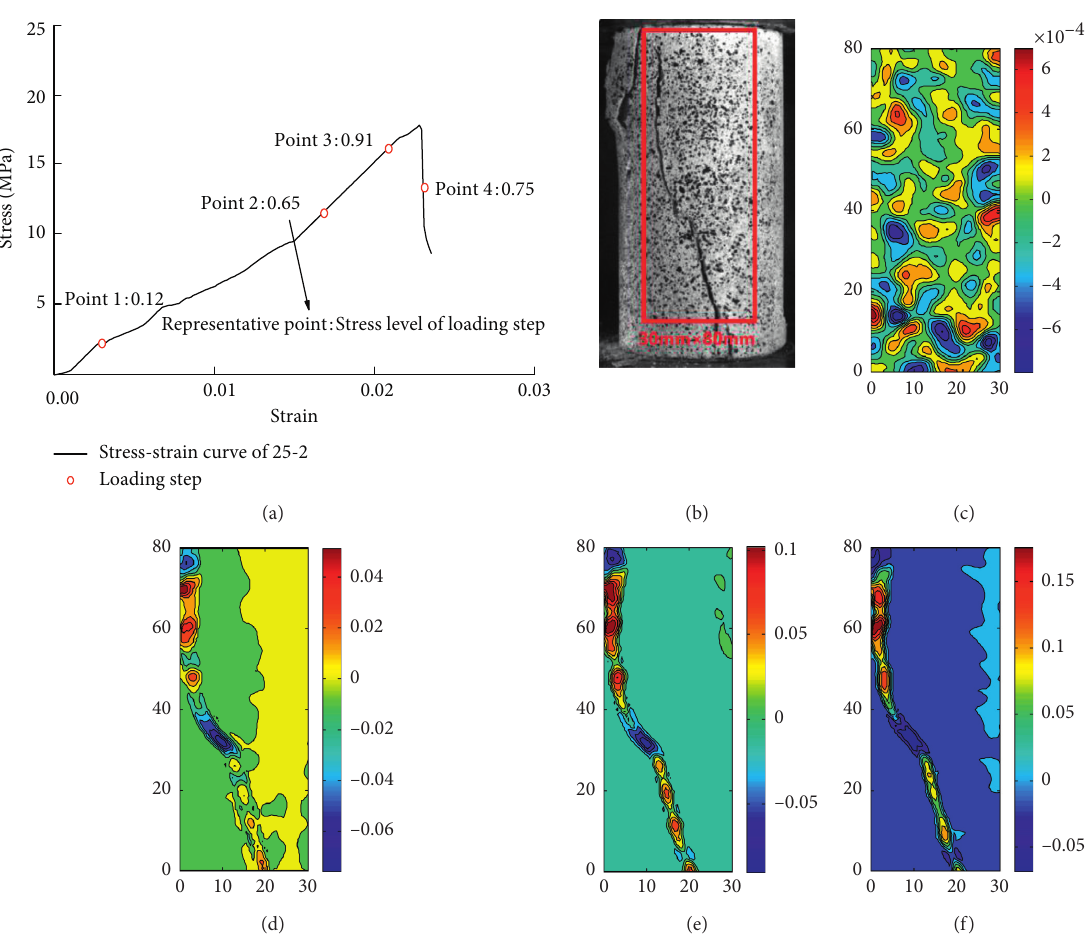
Figure 9: Evolution process of the lateral strain field of the feldspar sandstones (Group A) after the dry-wet cycles. (a) The curve of the representative points. (b) Destruction pattern. (c) Point 1 (d) Point 2. (e) Point 3. (f) Point